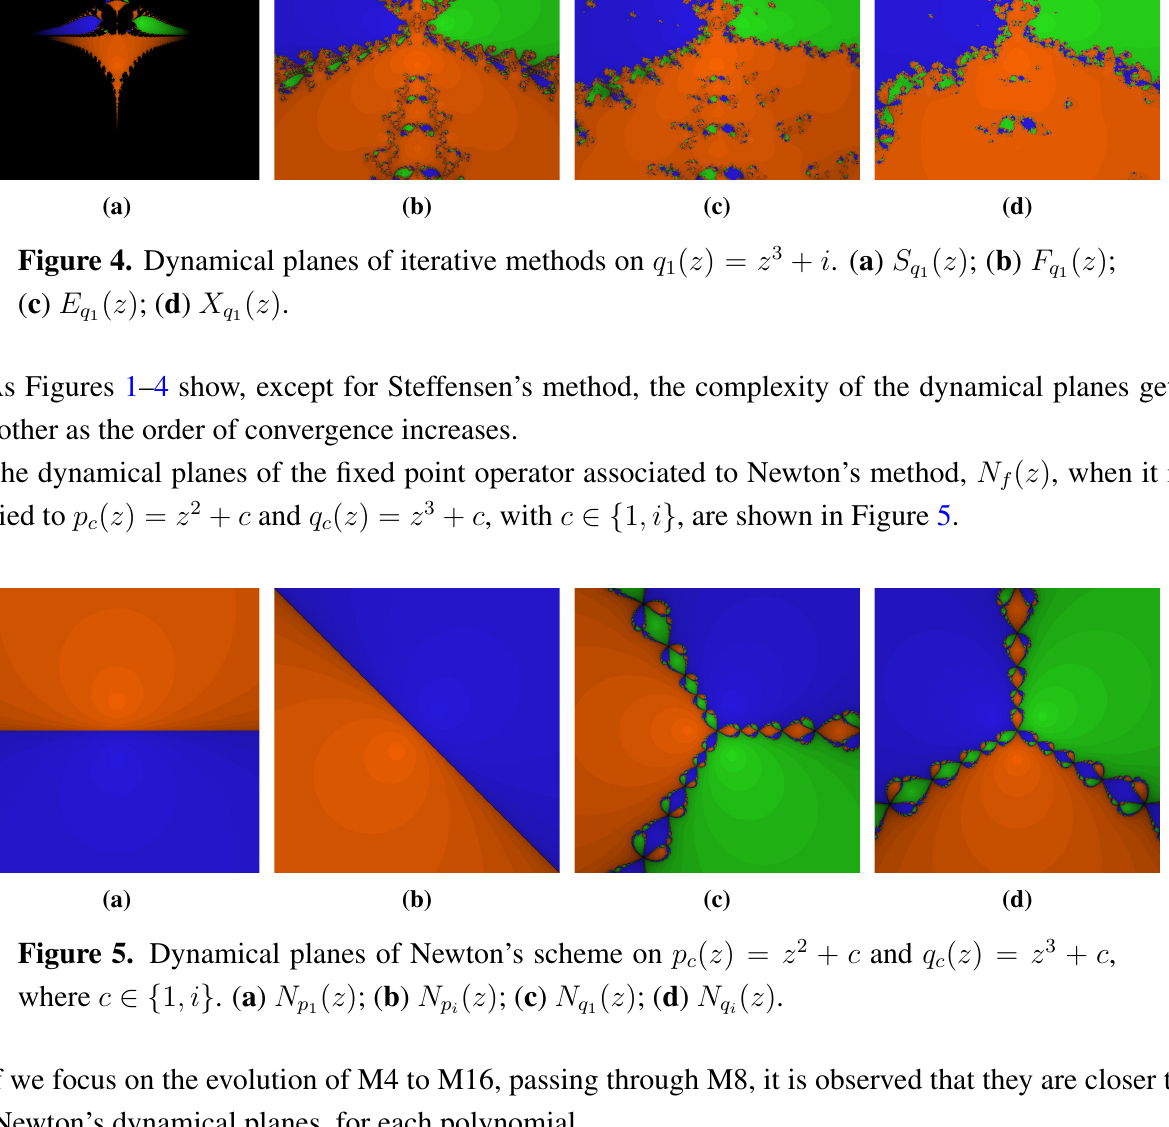
( z ) = z 2 + c and q c